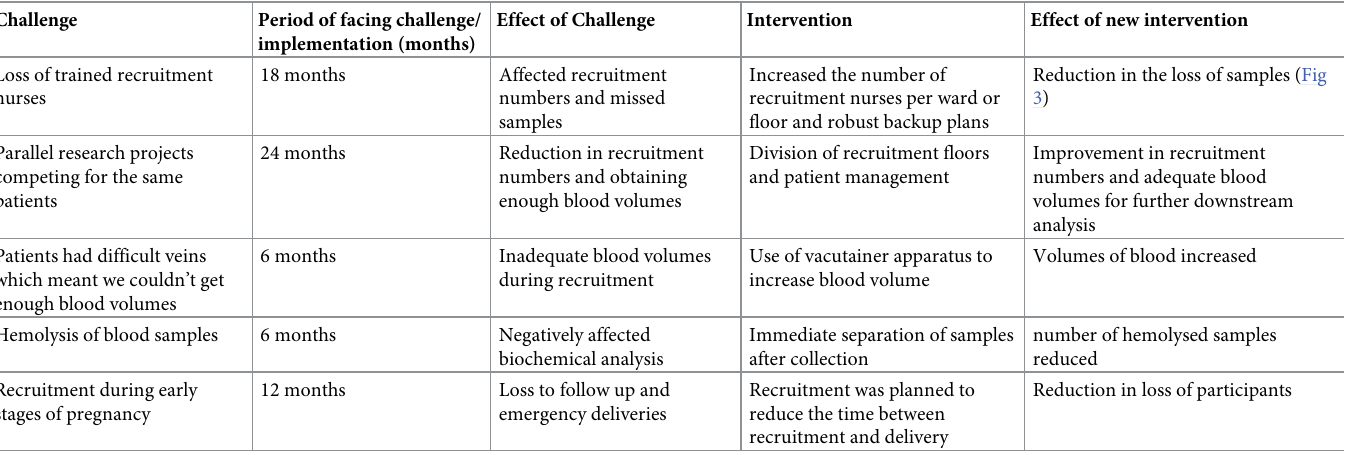
Table 6. Timelines of major challenges encountered and interventions implemented.